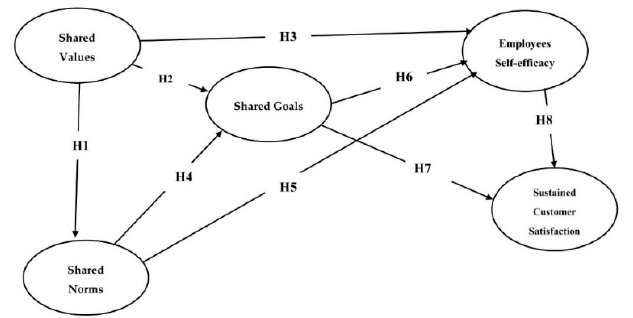
Figure 1. Research framework and hypotheses.